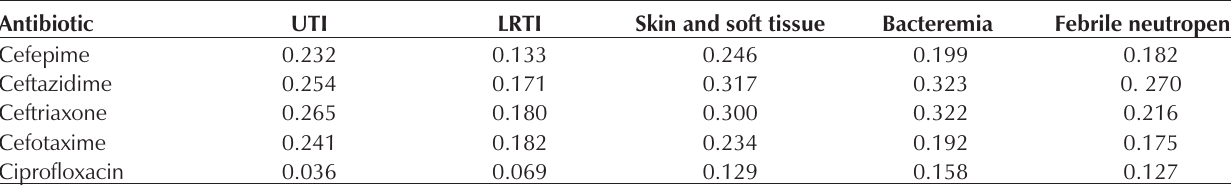
Probability of bacterial resistance* Antibiotic UTI LRTI